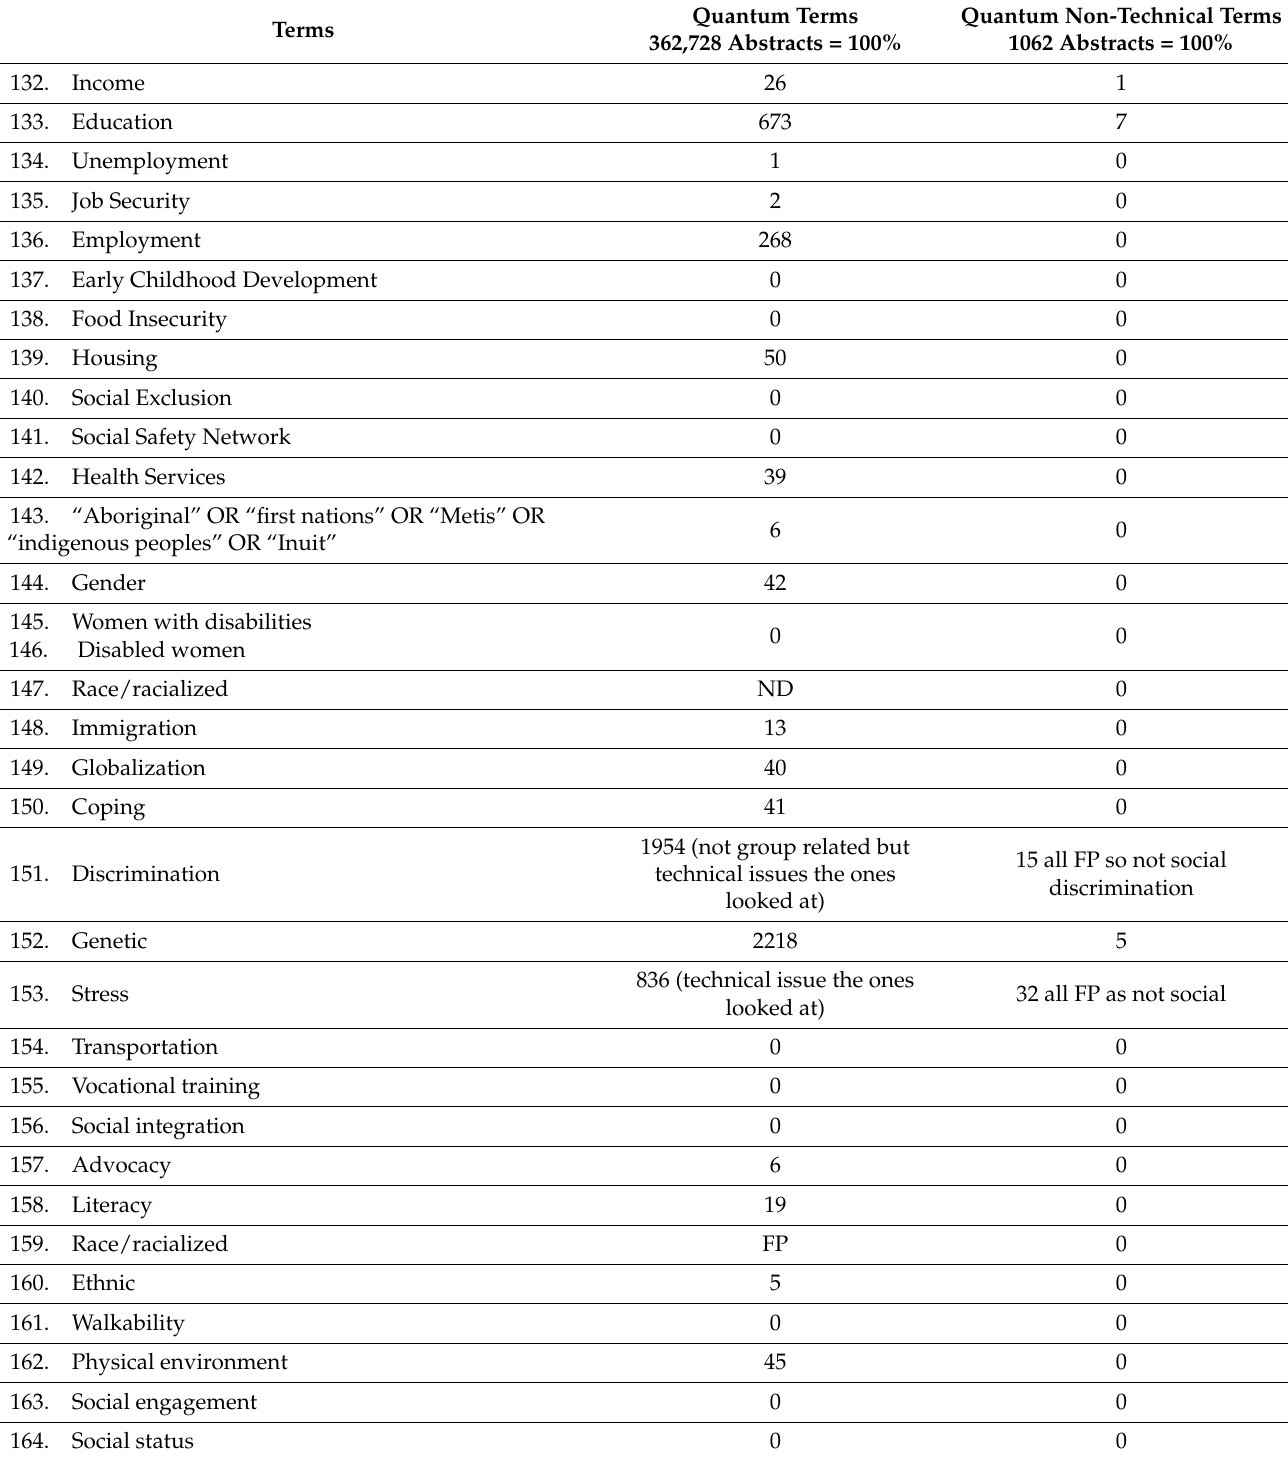
Table 8. Presence of Social determinants of health (SDH) indicators in conjunction with the quantum terms